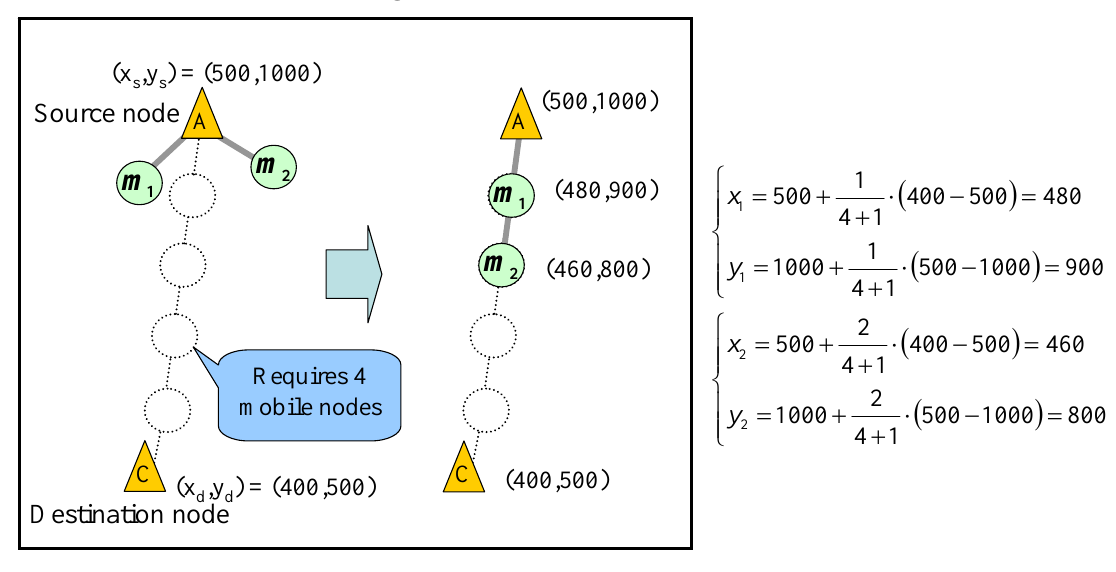
Figure 6. Construction of a train.